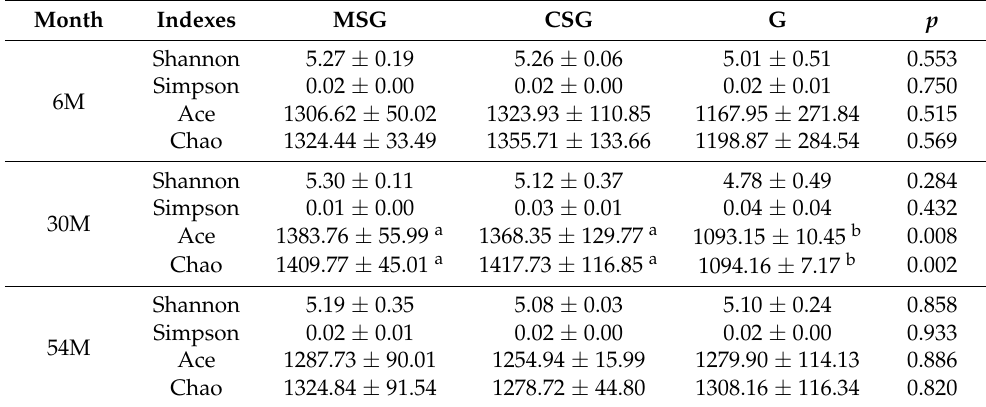
Table 8. Alpha diversity results of rumen microflora in Tianzhu white yaks supplemented with various